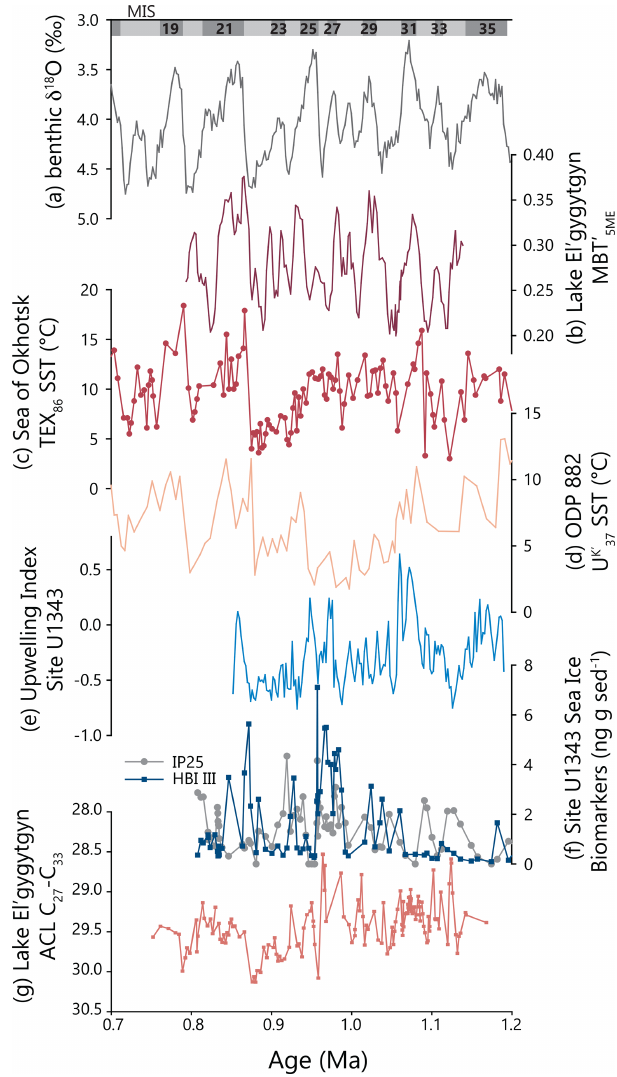
Figure 6. Comparison of the Lake El’gygytgyn temperature re- construction across the MPT with marine records from the sub- Arctic North Pacific (for locations of each site, refer to Fig. 1). (a) Global benthic oxygen isotope stack (Lisiecki and Raymo, 2005). (b) Smoothed (5-point moving average) Lake El’gygytgyn MBT (cid:48) 5ME values. (c) TEX 86 SST from the Sea of Okhotsk (Site (cid:48) MD01-2414; Lattaud et al., 2018). (d) U K SST from the sub-Arctic 37 North Pacific (ODP 882; Martínez-Garcia et al., 2010). (e) Up- welling index in the Bering Sea (Site U1343; Worne et al., 2020). (f) Concentration of sea ice biomarkers in the Bering Sea (Site U1343; Detlef et al., 2018). (g) Lake El’gygytgyn leaf wax ACL